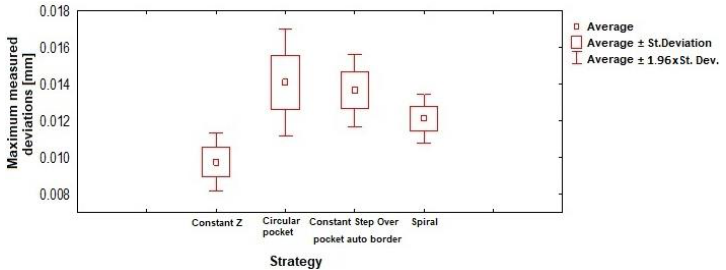
Figure 14. Roundness deviation without using UPR filter.